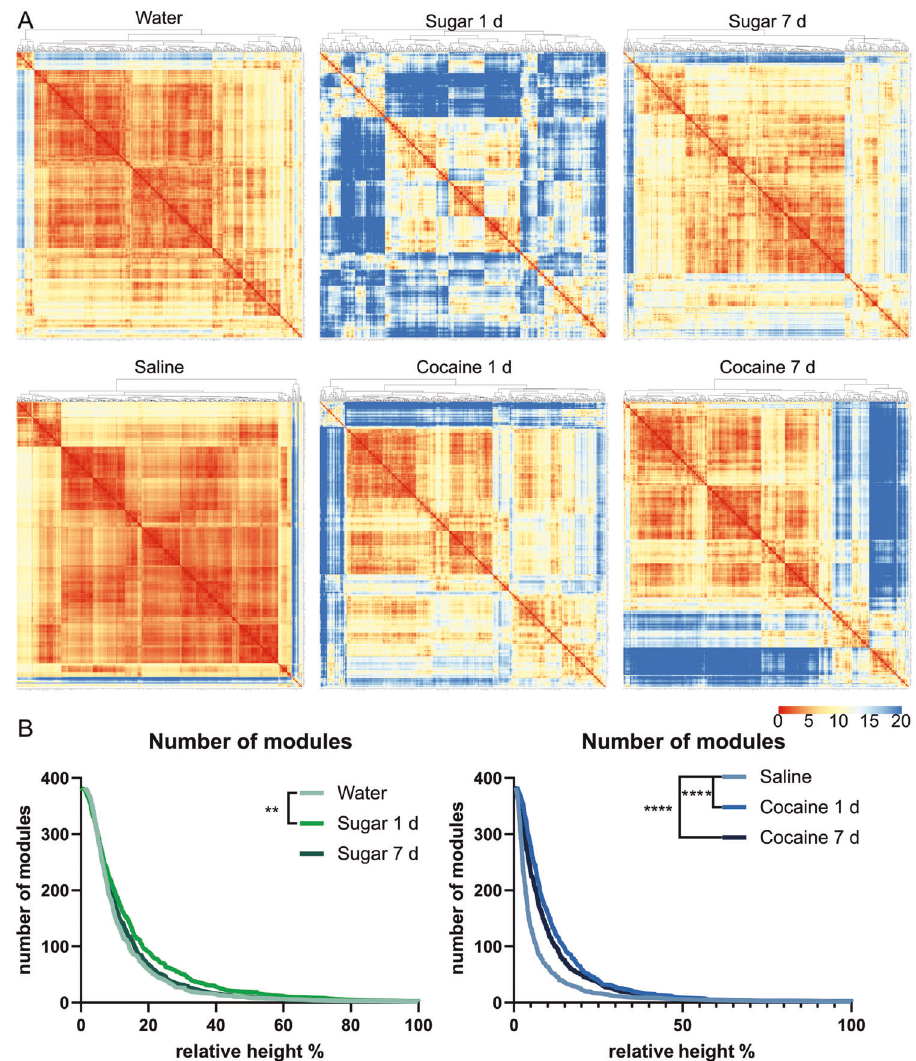
Fig. 4 Global pattern of the reorganization of the brain activity after sugar or cocaine exposure. A Hierarchical organization of sub- networks of brains of mice exposed to natural and pharmacological rewards. The Euclidean distance between brain structures was calculated to fi nd modules of similar brain structures. Graphs showing sub networks among brain structures created based on the distance between brain regions. Warmer colors indicate a shorter Euclidean distance, indicating that two structures have similar c -Fos signal density correlation patterns with other structures. On the top of each graph are dendrograms created based on Euclidean distances between structures (indicating the similarity of co-activation between structures). B Number of modules per group based on cutting the dendrograms at different percentages of tree heights (indicating different similarities between co-activated structures). Statistical difference was calculated with the Mantel-Cox test; Saline vs. Cocaine 1 d and Saline vs. Cocaine 7 d **** = p < 0.0001; Water vs. Sugar 1 d ** = p = 0.0013; Water vs. Sugar 7 d p = activation of brain structures throughout the whole brain, yet the pattern of such activation differs for both types of rewards tested. A single exposure to sugar causes a widespread activation that fades with repeated exposure. On the other hand, brain activation after cocaine potentiates with repeated injections. On the cellular level, in the ACB, repeated exposure to both cocaine and sugar triggered identical hallmarks of synaptic reorganization. However, on the network level, signi fi cant differences were observed in brain modularity, which increased after single sugar exposure and both acute and repeated cocaine injections.